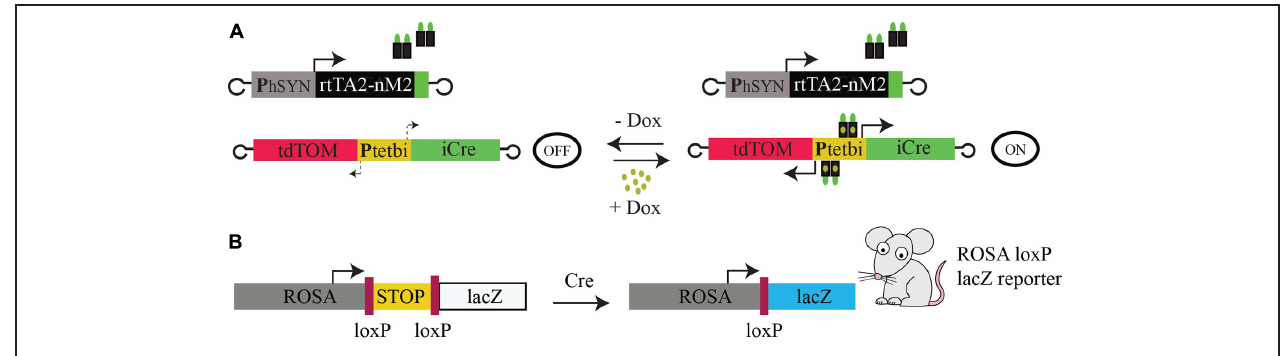
FIGURE 1 | Operating principles. (A) Schematics of rAAV-rtTA system; a virus with a human synapsin promoter for constitutive, pan-neuronal specific rtTA expression and another virus with a bidirectional tetracycline (tet) promoter (P tet bi) driving two different genes (tdTOM and iCre) in opposite directions. Binding of doxycycline (Dox) to rtTA enables it to bind to P tet bi, and gene expression is bidirectionally switched-ON. In the absence of Dox, rtTA is unable